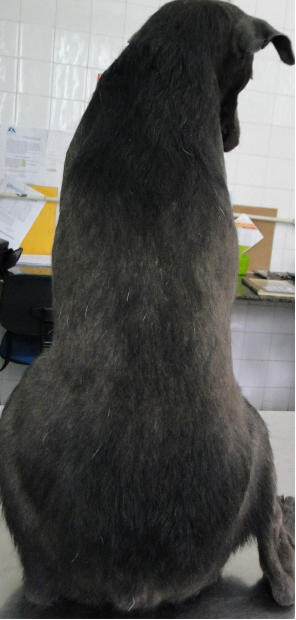
Figura 1. Canino SRD, diagnosticado com alopecia por diluição da cor, atendido no setor de Dermatologia do